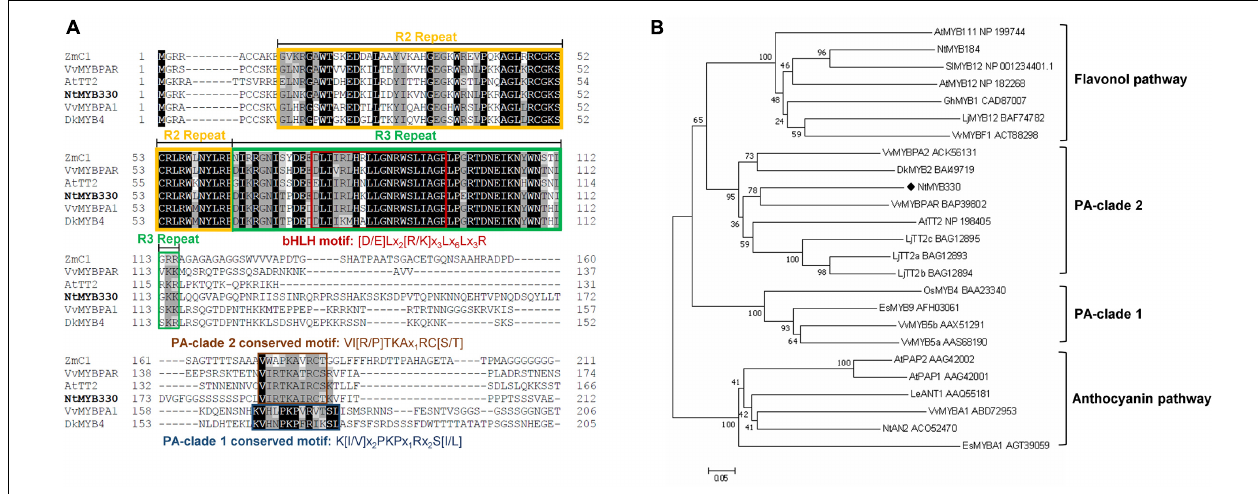
FIGURE 1 | Multiple alignment and phylogenetic analysis of selected R2R3-MYB proteins. (A) The deduced amino acid sequence of NtMYB330 was aligned with R2R3-MYB homologous ZmC1 (AAA33482) from Zea mays , VvMYBPAR (BAP39802) and VvMYBPA1 (CAJ90831) from Vitis vinifera , AtTT2 (NP198405) from Arabidopsis thaliana , DkMYB4 (BAI49721) from Diospyros kaki . The R2 and R3 repeats are boxed in orange and green, respectively. The bHLH motif [D/E]Lx 2 [R/K]x 3 Lx 6 Lx 3 R, PA-clade 1 conserved motif K[I/V]x 2 PKPx 1 Rx 2 S[I/L] and PA-clade 2 conserved motif VI[R/P]TKAx 1 RC[S/T] are indicated in red, dark blue, and brown boxes, respectively. (B) The phylogenetic tree of NtMYB330 along with selected R2R3-MYBs was constructed using neighbor-joining method. Scale bar represents 0.05 substitutions per site and numbers next to nodes are bootstrap values from 1000 replicates. GenBank accession numbers are indicated next to the protein